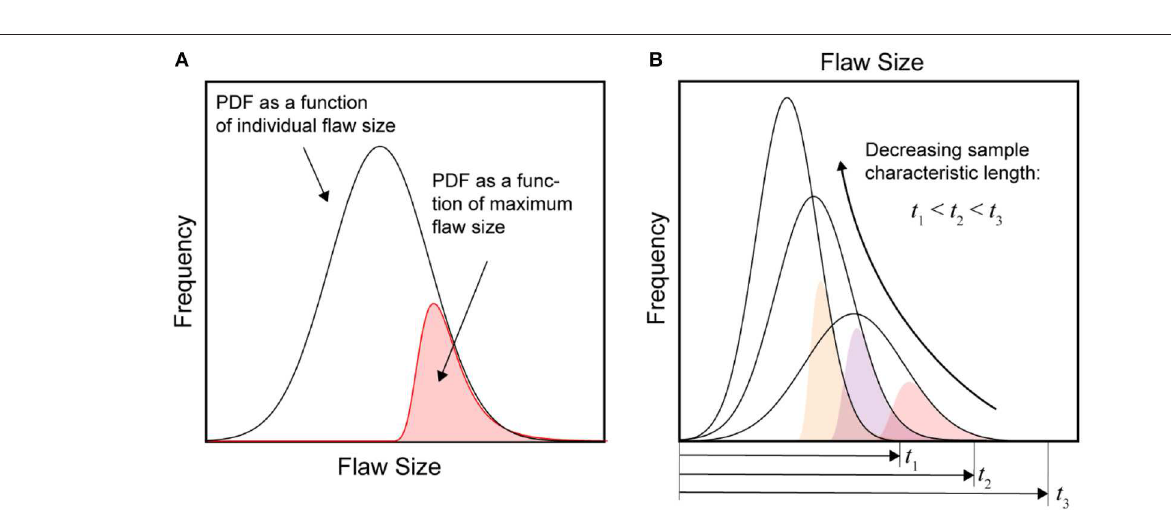
FIGURE 3 | (A) Probability density distribution as a function of the maximum flaw size and its association with that of individual flaw size. (B) Schematic illustration showing the sample size confinement effects on the parent and maximum flaw size